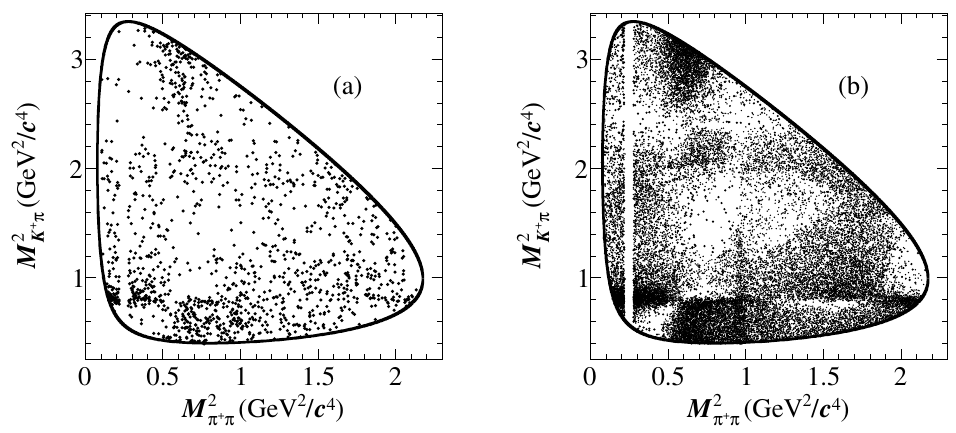
versus M 2 of the selected DT candidates from (a) the Figure 2 . The Dalitz plots of M 2 K + π − π + π − data sample and (b) the signal MC sample generated based on the amplitude analysis results at √ s = 4 . 178 − 4 . 226 GeV . The black lines indicate the physical